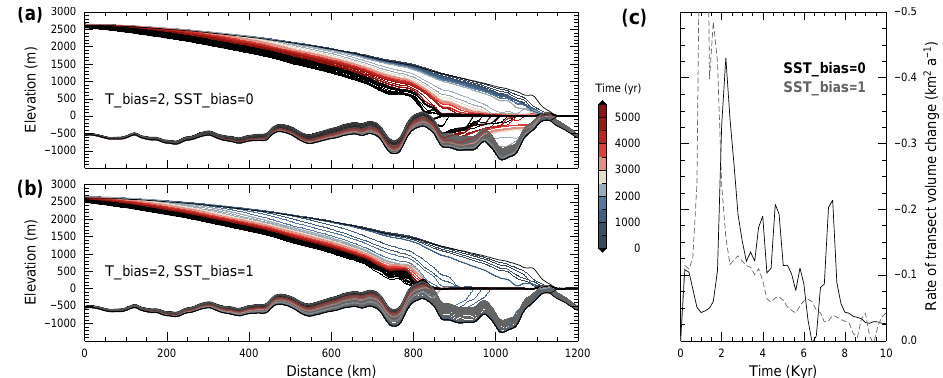
Figure 7. Mechanism and timescale of ice-sheet retreat across Wilkes Subglacial Basin. (a) Ice-sheet margin initially occupies stable location pinned on bedrock high, unaffected by marine influence. Gradual surface lowering from rising air temperatures promotes thinning, flotation, and subsequent rapid inland retreat of margin. (b) Identical simulation to (a) but employing a warmer ocean. Coloured lines denote ice geometries at 200-year intervals. Note also the associated bedrock uplift following ice retreat. (c) Rate of retreat across the WSB is non- uniform, despite time-invariant forcings, and is governed primarily by the location of bedrock pinning